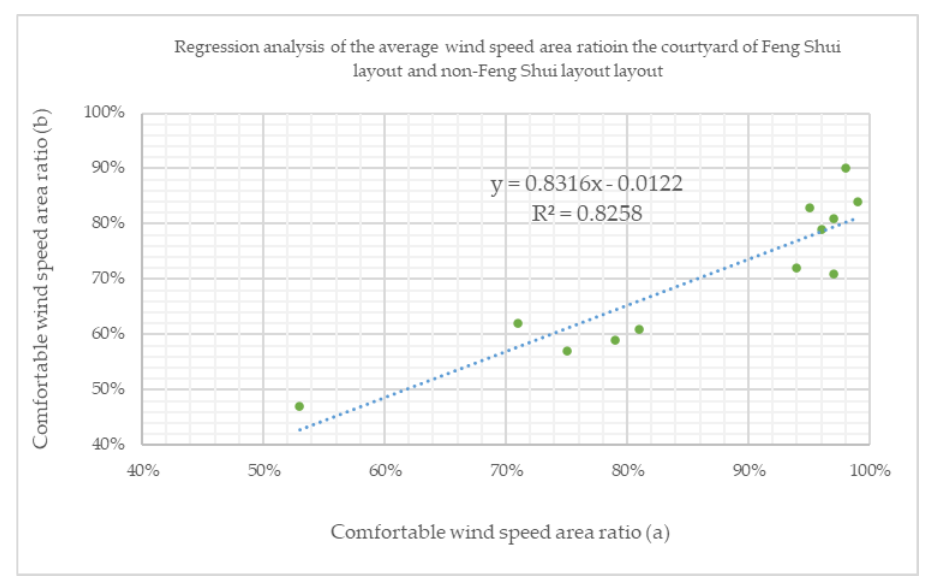
Figure 18. Regression analysis of the average wind speed area ratio in the courtyard of Feng Shui layout and non-Feng Shui layout. The data for the graph were obtained through CFD simulations.